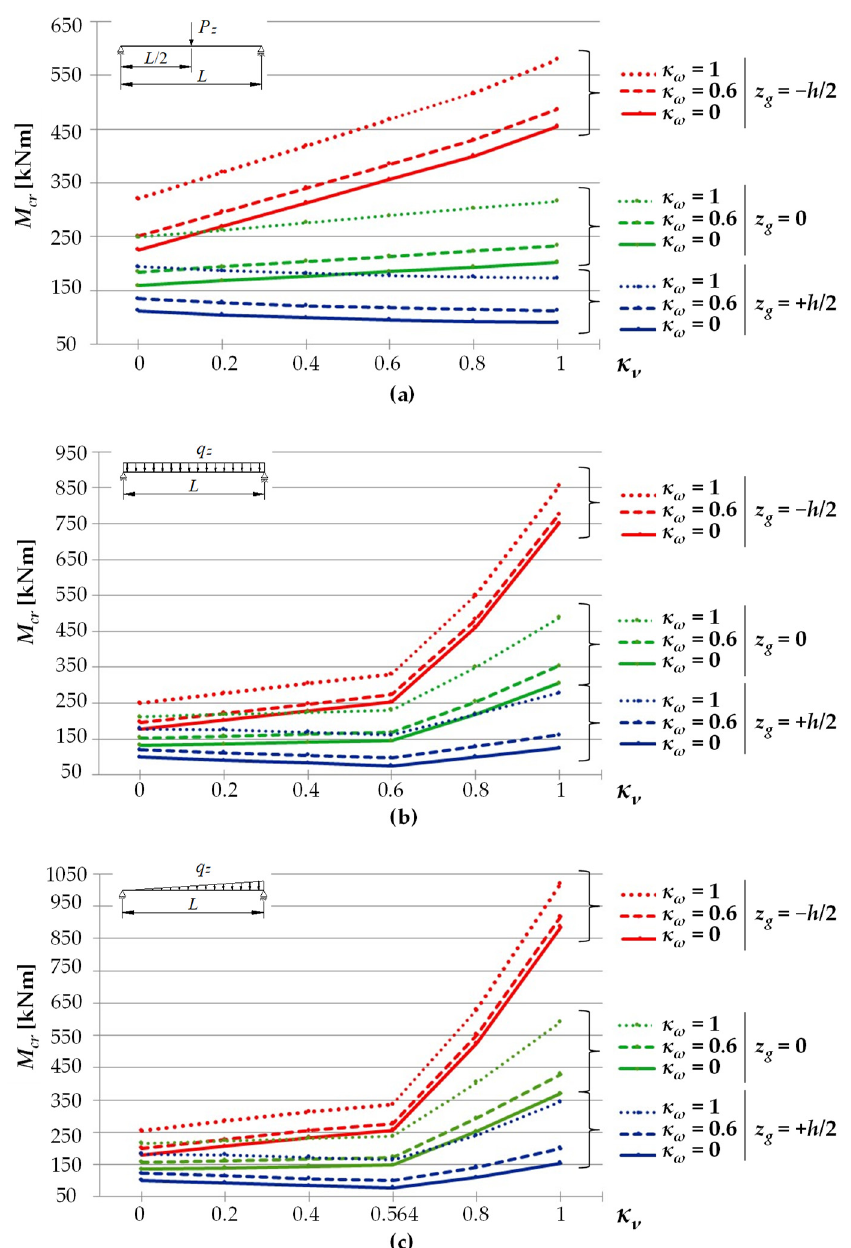
Figure 5. Critical moments of LTB M cr for an IPE300 ( L = 5 m) beam as a function of the κ ν index for selected κ ω indices: ( a ) concentrated force load, ( b ) uniform load, ( c ) triangularly distributed load.